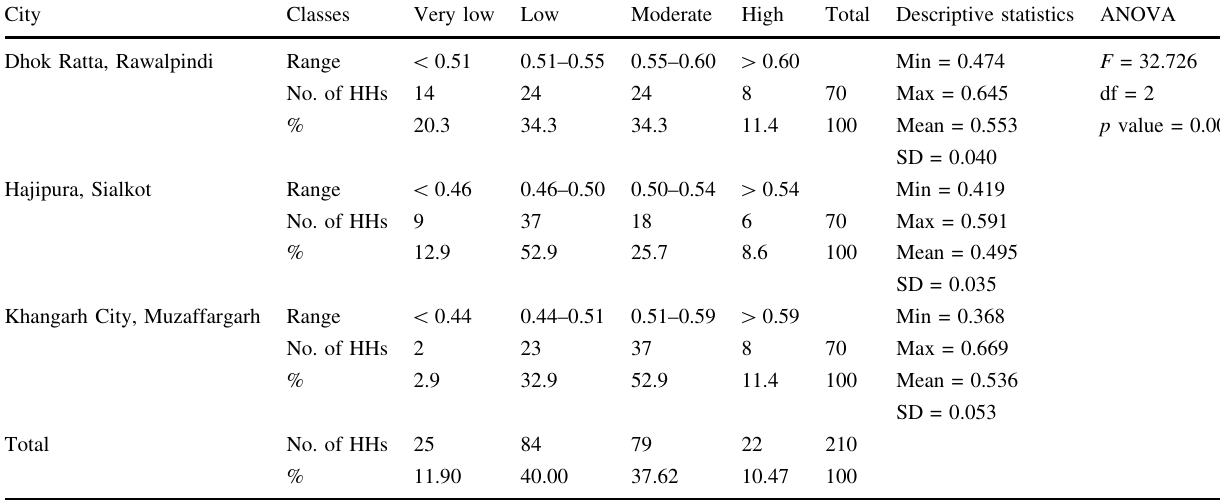
Rana and Routray. Multidimensional Model for Vulnerability Assessment of Urban Table 7 Multidimensional vulnerability to urban flooding in Dhok Ratta, Hajipura, and Khangarh City, Punjab Province, Pakistan (HHs = Households; n = 210) City Classes